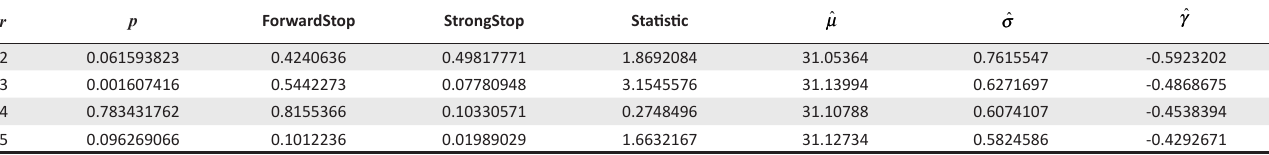
TABLE 2: Entropy difference test for diagnosing generalised extreme value distribution for r largest order statistics. r p